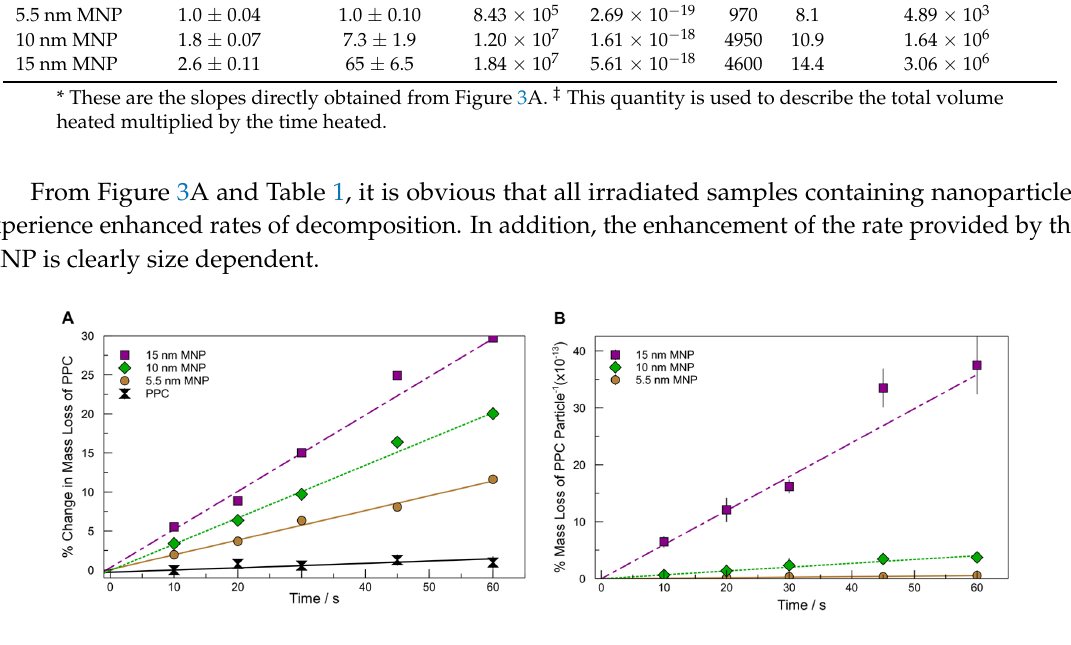
Table 1. Collection of various experimental and theoretical values discussed herein. In this table, (cid:101) 532 is the extinction coefficient at 532 nm, C p is the heat capacity of a single particle, T max is the maximum temperature the particle reached during simulated photothermal heating and t T particle was above the reactive temperature for the decomposition of PPC, poly(propylene carbonate).